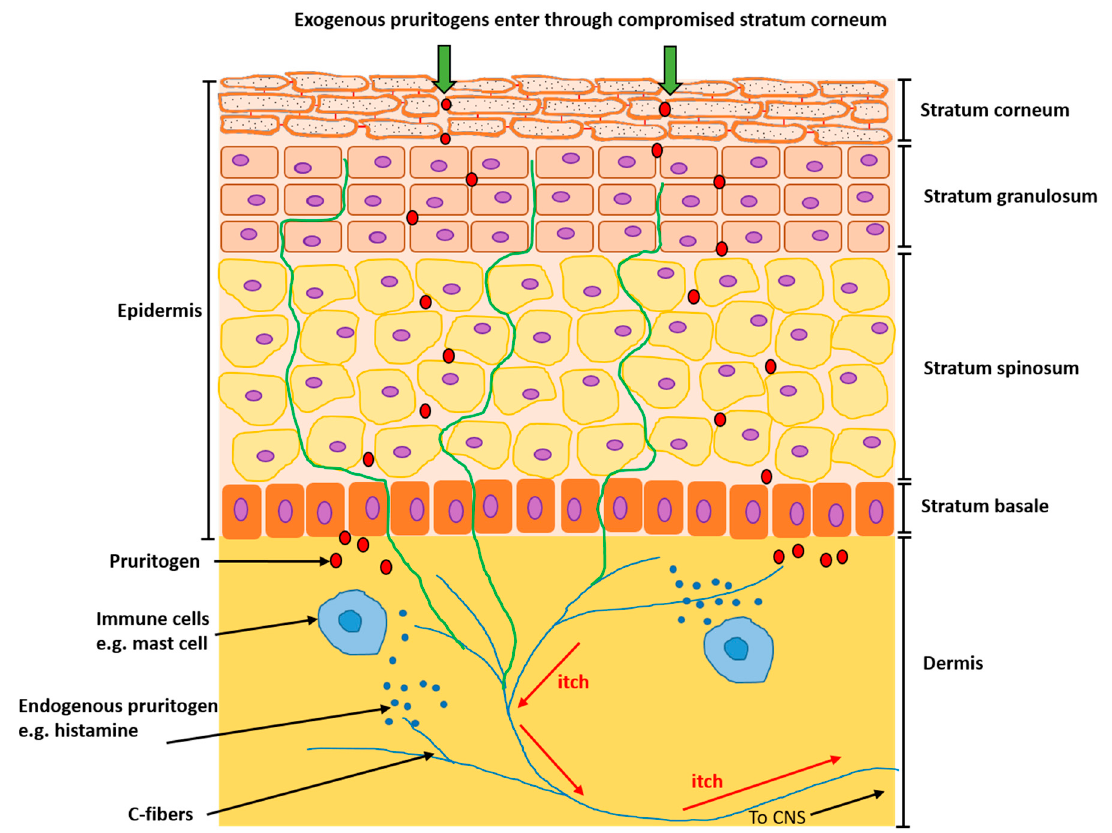
Figure 1. The itch pathway. Exogenous itch-causing substances, pruritogens, enter through the compromised stratum corneum and journey through the layers of the skin until they bind to their receptors on sensory a ff erent nerves, or C-fibers (in blue), triggering a signal which travels up the central nervous system (CNS) to the brain, where it is recognized as an itch. In addition, endogenous pruritogens such as histamine can be produced by cells of the body, such as mast cells. Nerve distribution and density is increased within the epidermis in AD skin (in green).